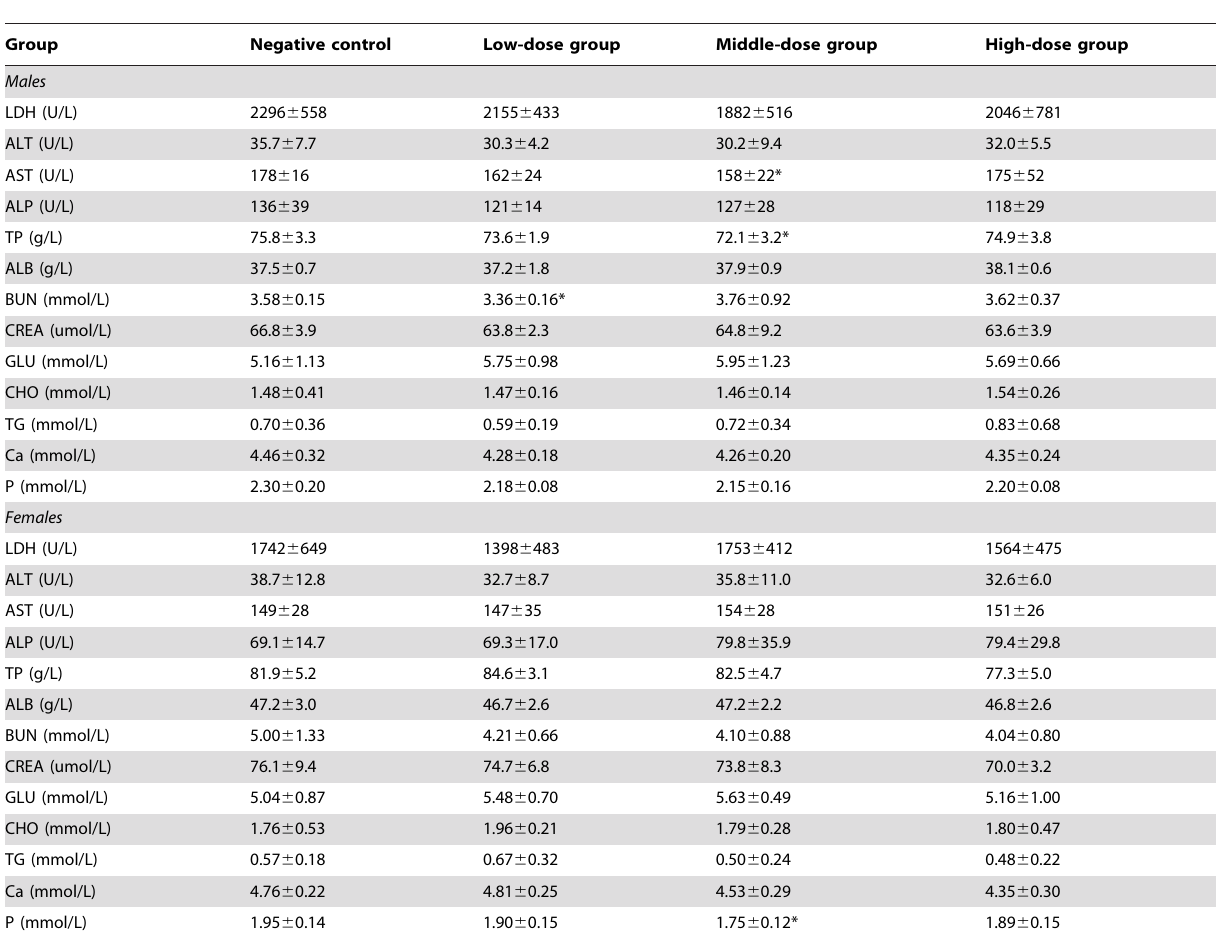
Table 8. Terminal serum chemistry values of rats fed lactase for 90-days (mean 6 SD, n